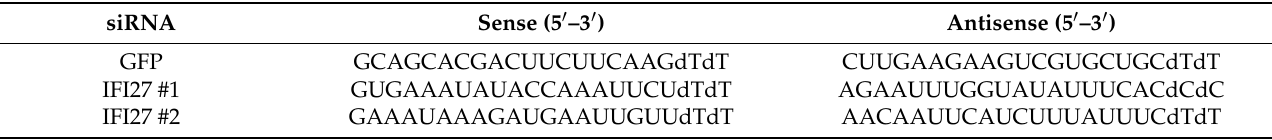
Table 4. Sequences of small interfering RNAs